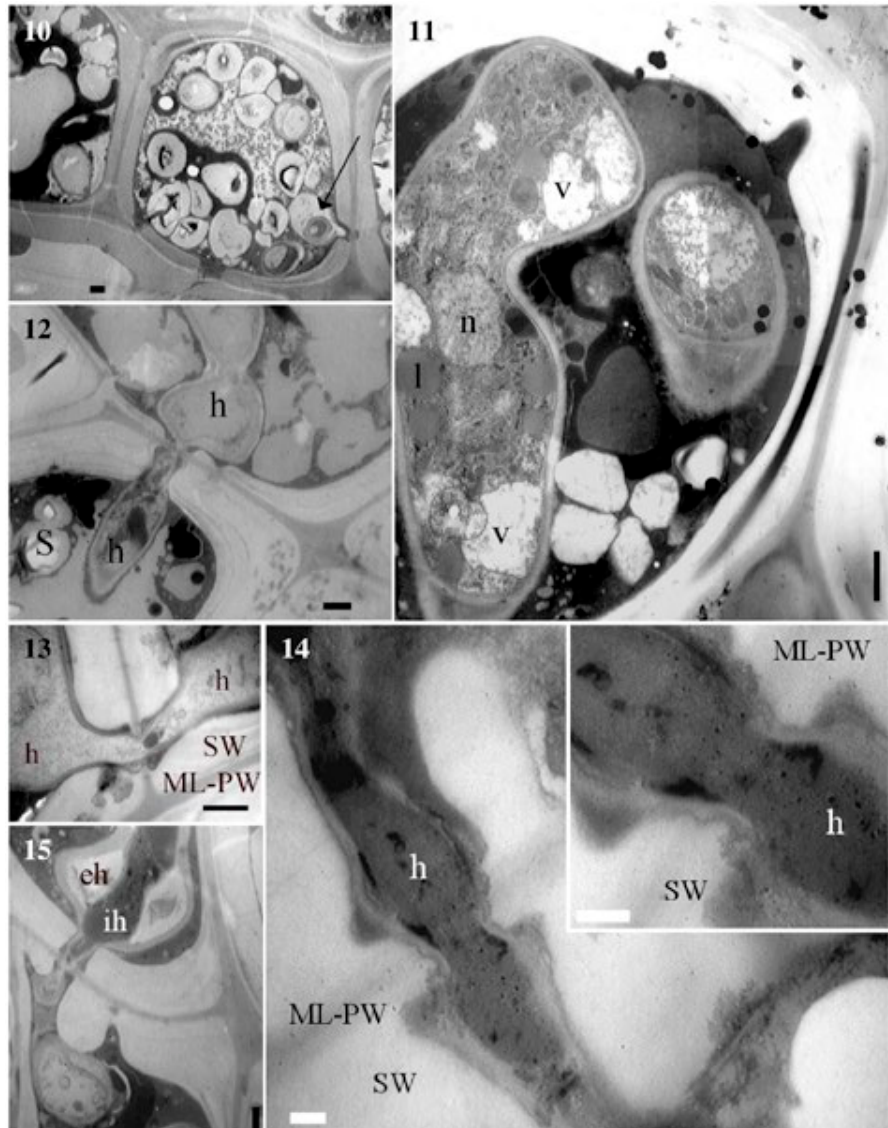
Plate C. Figure 10. Infected woody sample. Parenchymatic cells comprising some hyphae (arrow), with degraded starch grains and plastid membranes. The cytoplasm shows residues of degraded organelles; the plasmalemma and cell walls are apparently undamaged. Figure 11. Two hyphae in a collapsed parenchymatic cell. The cytoplasm accumulates highly electron-dense amorphous material. TEM. Figure 12, 13, 14, 15. Hyphae crossing a pit between two parenchymatic cells. In particular: (12) The hyphal size decreases in the passage. The plant cell wall is not altered, and the middle lamella-primary wall complex in the pit is not distorted. TEM. (13) Only a small portion of the pit’s membrane is affected by the perforation. The fungal wall is partially decondensed. TEM. (14) Hypha crossing a pit and its magnification on the right. A part of the pit’s membrane is degraded, allowing hyphal passage without distortion. Electron-dense material is present all around the passage. The hypha has a wider diameter in the upper part of the passage, indicating the direction of growth. TEM. (15) A degenerated hypha contains an osmiophilic fungal structure shrinking and crossing the pit membrane inside the external one, with no further damage to the middle lamella. (fungal structures: eh, external hypha; h, hypha; ih, intrahyphal hypha; l, lipid droplet; n, nucleus; v, vacuole; plant structures: ML-PW, middle lamella–primary wall complex; S, starch grains; SW, secondary wall; white bar, 200 nm; black bar, 1